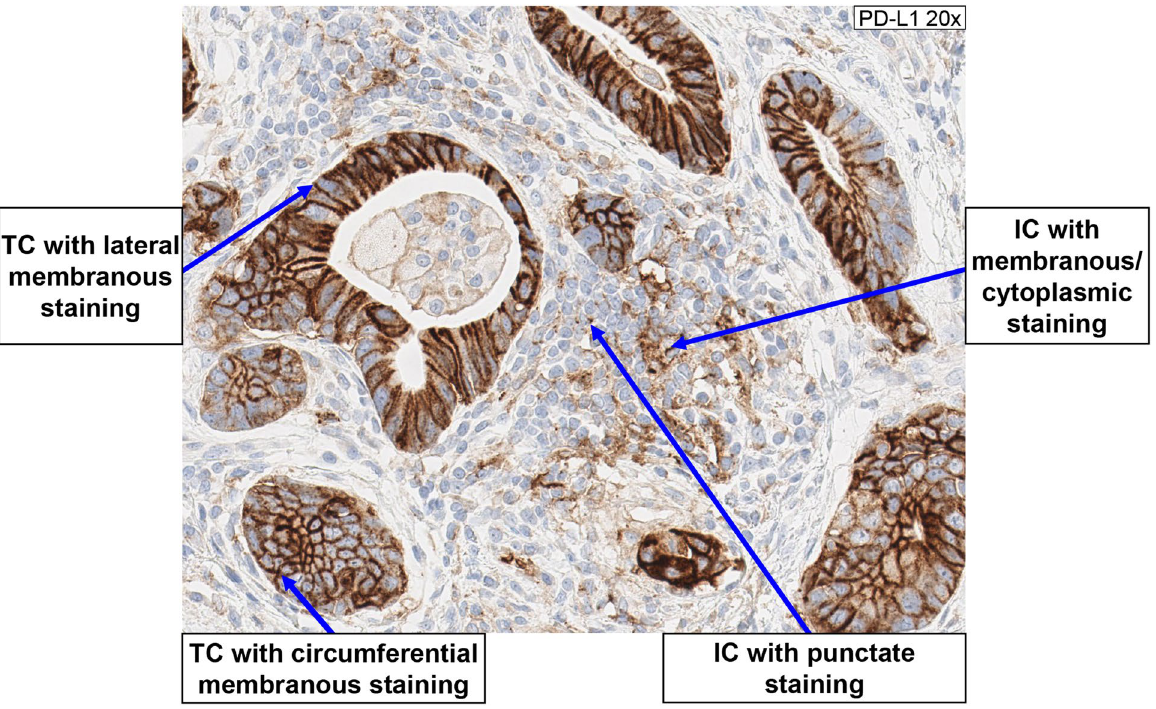
Fig. 3 PD-L1 positive staining. Both circumferential and partial/lateral membrane staining of TC at any intensity is regarded as positive PD-L1 staining, while cytoplasmic staining of TC is disregarded; membranous, cytoplasmic, and punctate staining of tumor-associated IC at any intensity is regarded as PD-L1 positive staining. IC immune cells, PD-L1 programmed death-ligand 1, TC tumor